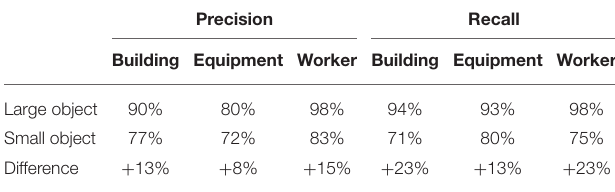
TABLE 2 | Performance of the best model in detecting less and more crowded objects. Precision